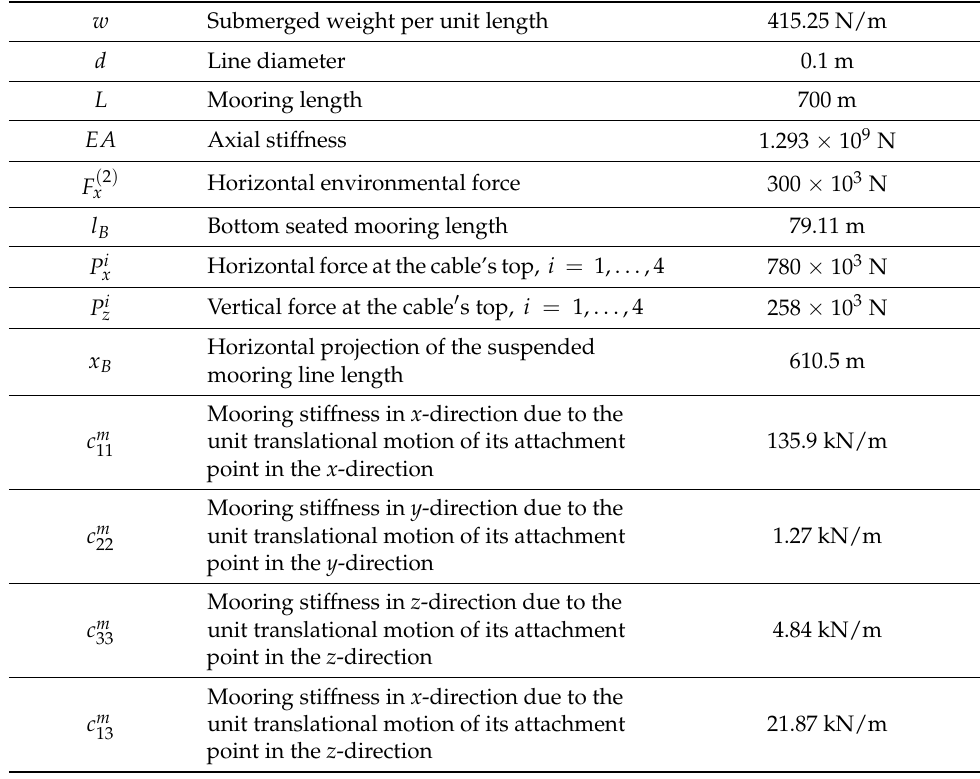
Table 1. Mooring characteristics.